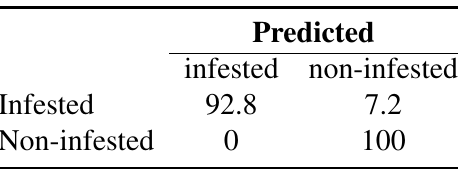
Table 3. Canonical discriminant classification showing the percentage of correct group classification in a binary classification (first sampling date).